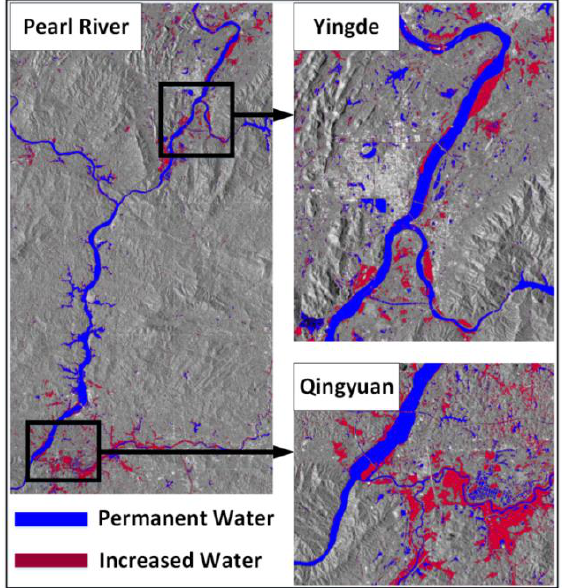
Figure 3 The extent of flooding in the Beijiang basin of the Pearl River.